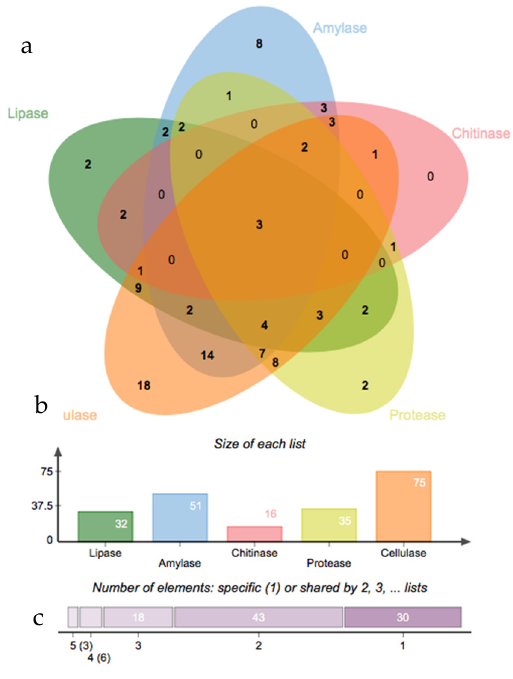
Figure 5. Number of isolates expressing different extracellular enzymatic activities ( a ); number of isolates expressing each extracellular enzymatic activity ( b ); number of isolates combining the expression of 1, 2, 3, 4 or 5 different activities ( c ).